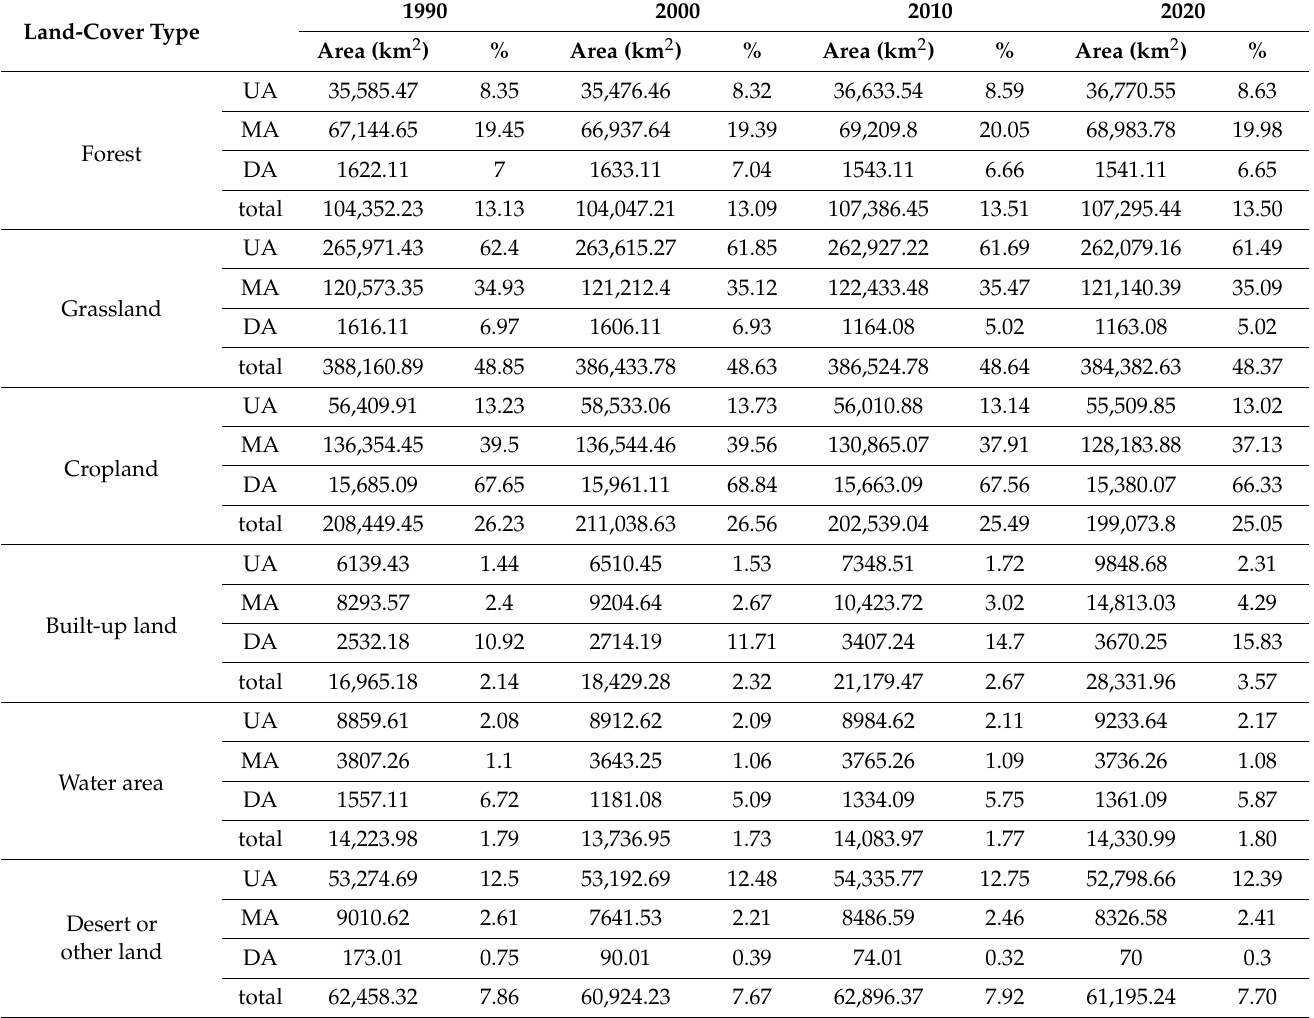
Table 1. The areas of land cover in the YRB area during the period from 1990 to